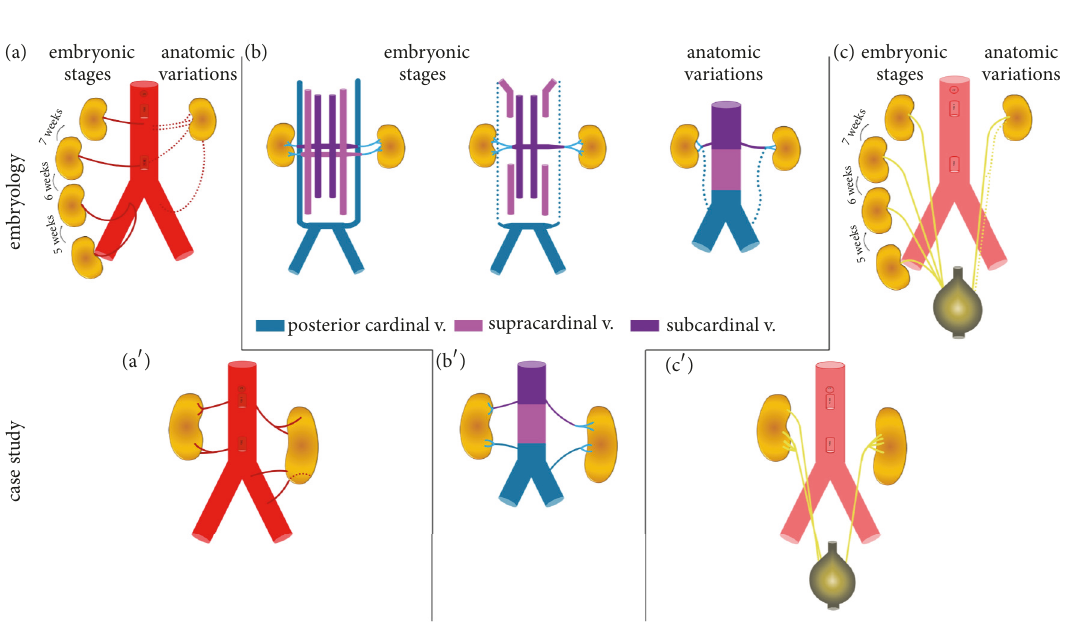
Figure 5: Simplified schematic representation of renal development . Around 5 weeks of fetal life, kidneys are formed from the metanephros. They are situated at the level of the pelvis and pelvic branches of the common iliac artery provide initial arterial blood supply. During the following 3 weeks, the kidneys ascend in the abdominal cavity (a) to their adult retroperitoneal location. As they move cranially and the metanephros coalesces, the lower arteries degenerate to, most often, leave a single renal artery as the main arterial supply. Occasionally, the temporary arteries (dotted lines (a)) do not degenerate leading to anatomical variations in the adult (a 󸀠 ). The cardinal systems contribute to the developing venous network of the kidney as it ascends (b). Persistence of some aspects of the developing venous network may lead to anatomical variations in the adult (dotted lines (b), (b 󸀠 )). More than one ureteric bud may penetrate the metanephric mesoderm during ureteral development (c) that results in duplex kidney (left (c 󸀠